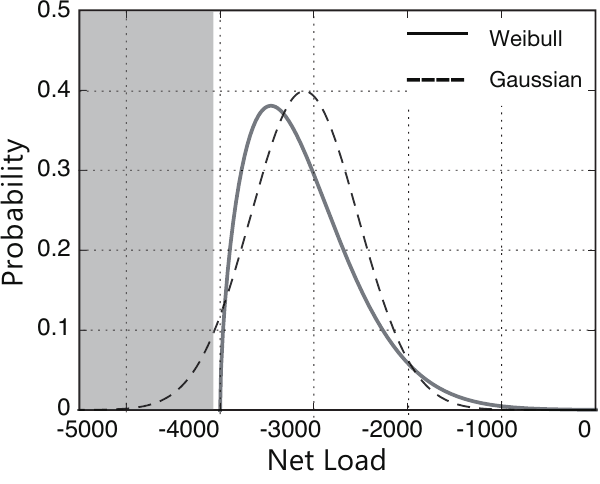
Figure 1. Gaussian and Weibull distributions with equal mean values and standard